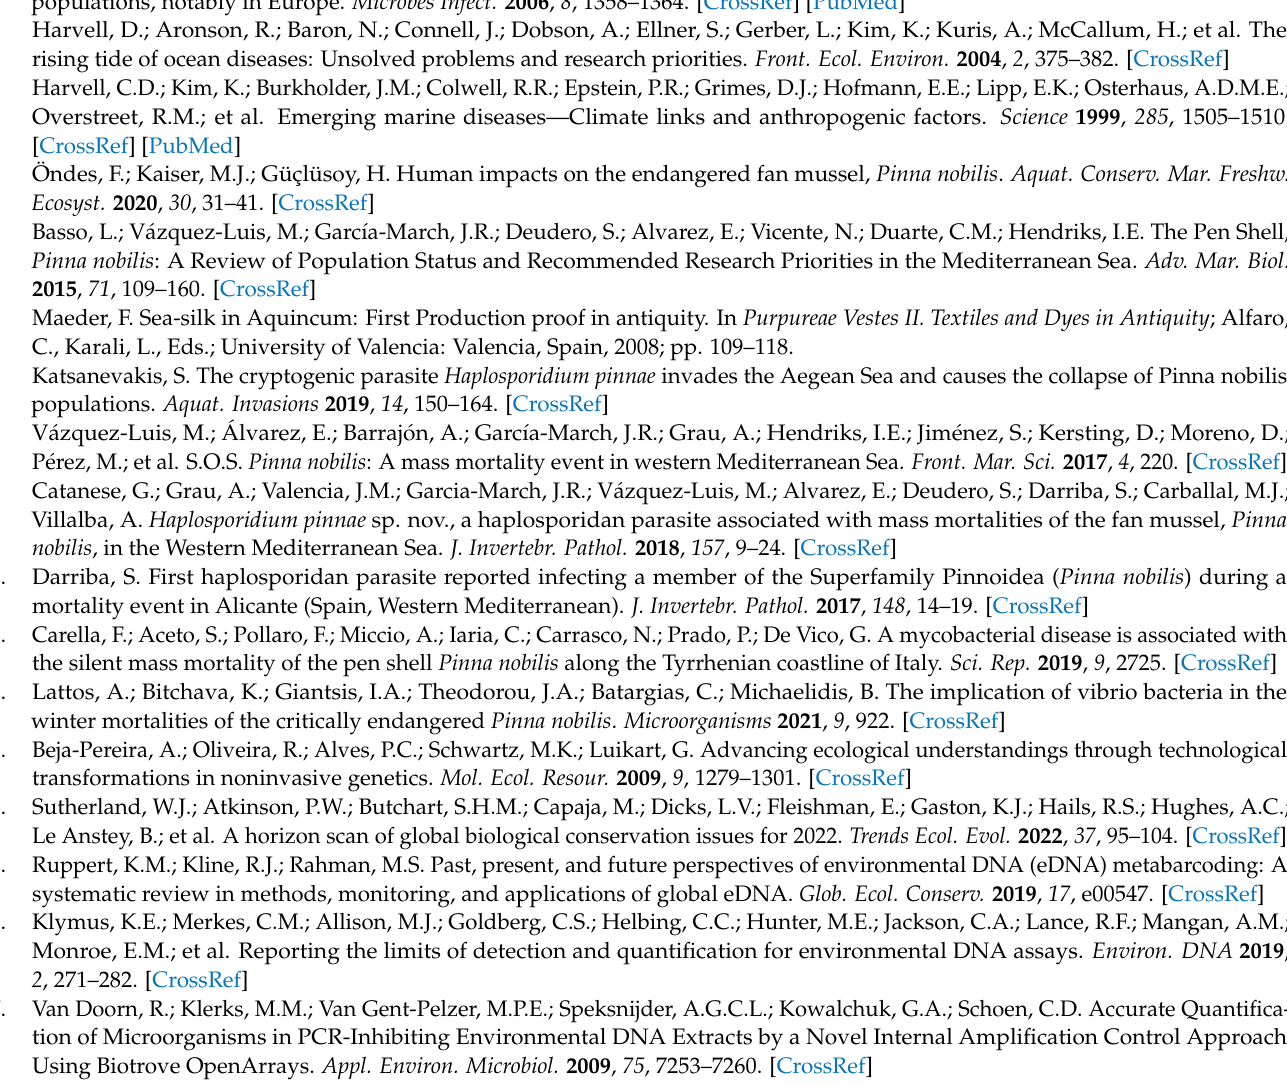
Figure S2: Standard curve plot on inhibition test, Figure S3: Alignment of the Sanger sequenced amplicon by F8 with other Haplosporidium spp. and along with Hp_CM